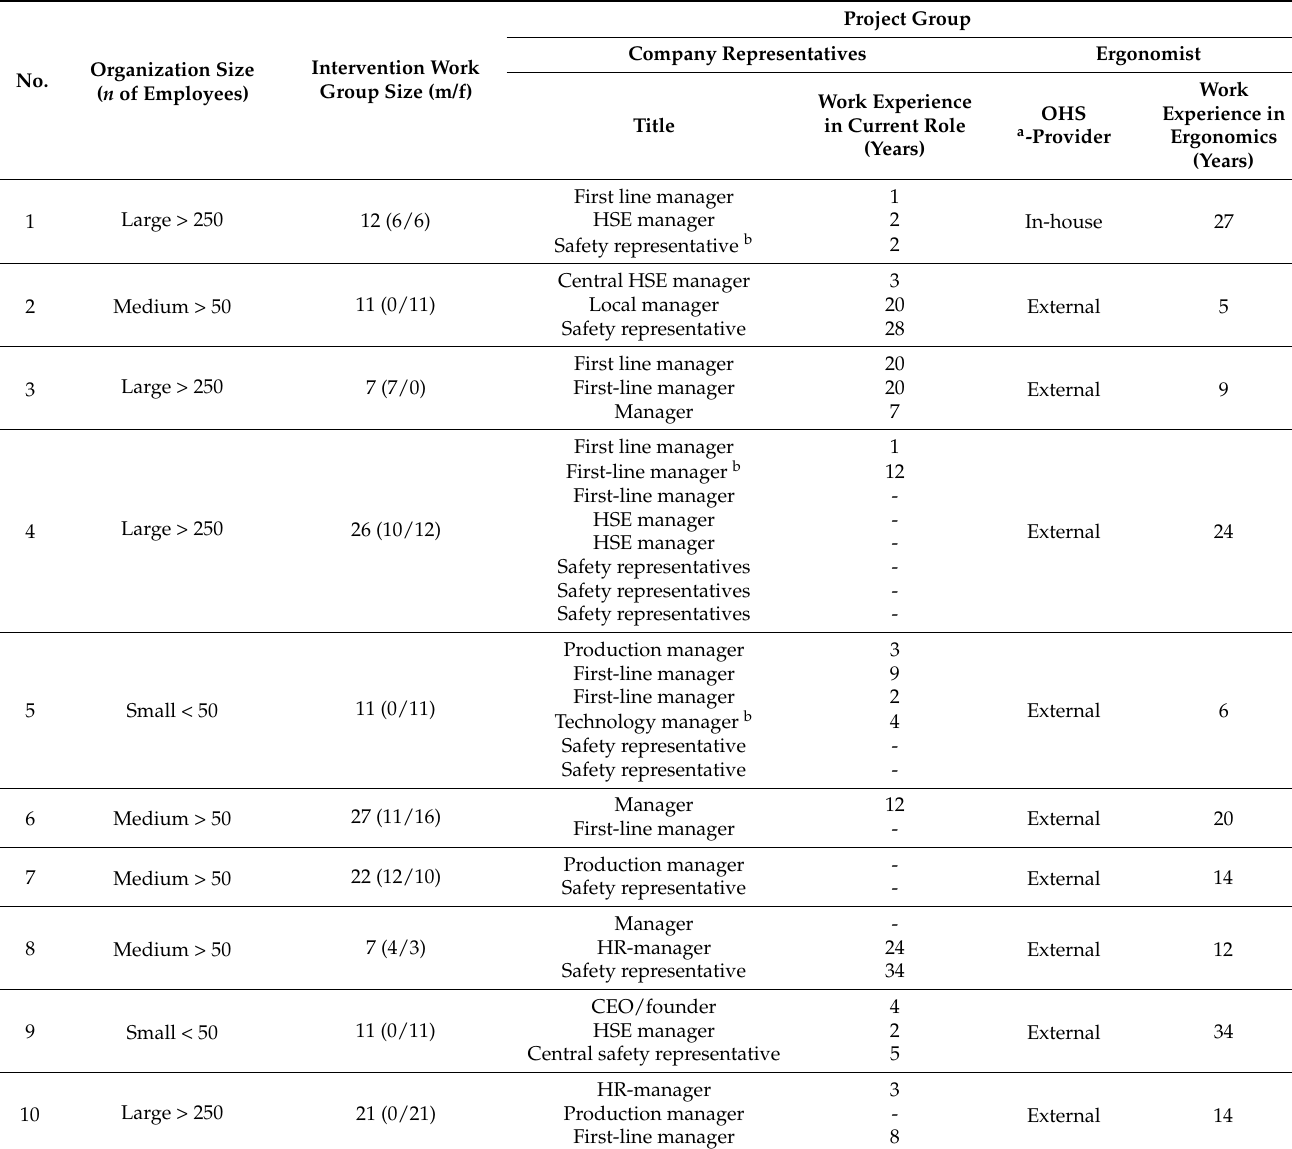
Table 1. Description of included companies. All company representatives except those described as “central” worked at the local site, where the occupational health surveillance took